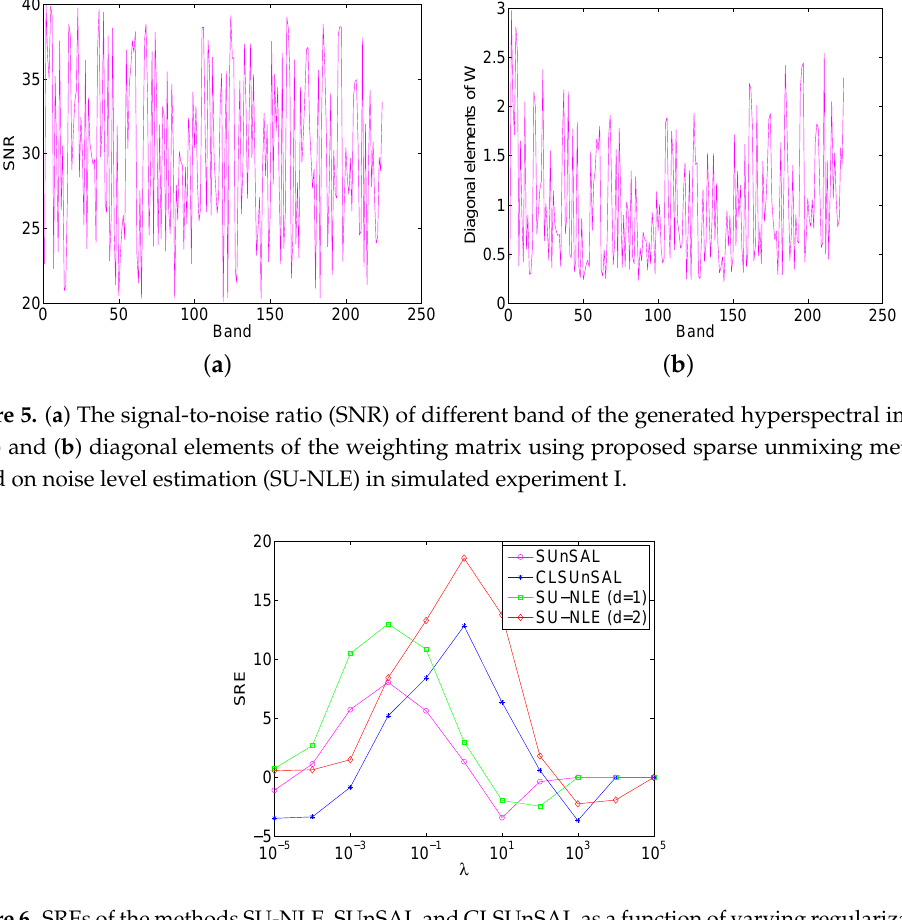
Figure 6. SREs of the methods SU-NLE, SUnSAL and CLSUnSAL as a function of varying regularization parameter λ under Gaussian white noise with both pure and mixed regions having 75 × 75 pixels and 224